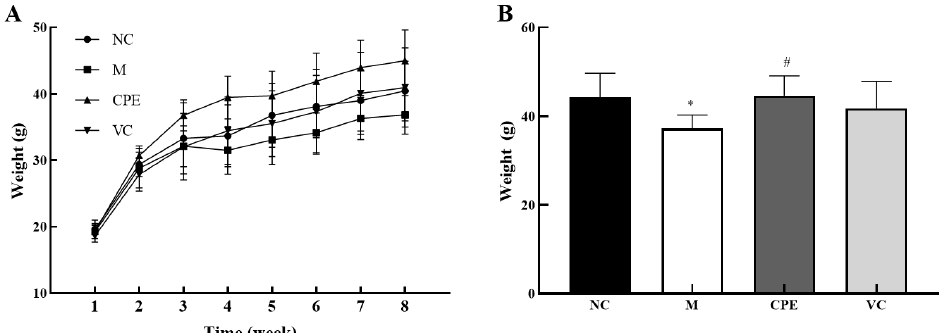
Figure 2. Body weight changes of mice during the experiment. Note: ( A ): the weight growth of mice during the experiment; ( B ): the weight of mice at the eighth week. “*” indicated that the date had statistically significant differences ( p < 0.05) compared with group NC. “#” indicated that the date had statistically significant differences ( p < 0.05) compared with group M. NC, negative control group; M, model group; CPE, treatment group; VC, positive control group.